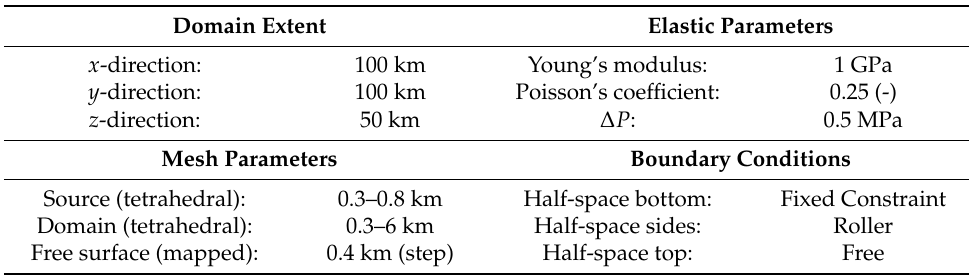
Table 1. Parameters of FE simulated deformation